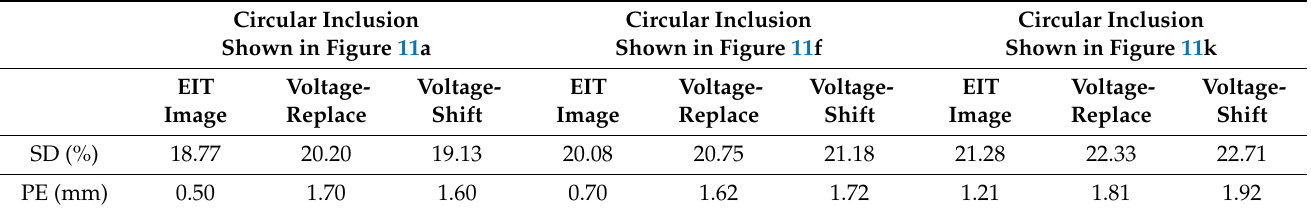
Table 2. Shape deformation (SD) and position error (PE) values of the EIT images, as shown in Figure